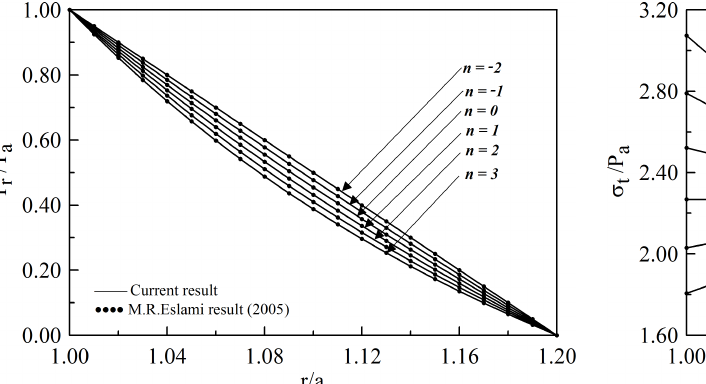
Figure 6: Radially distributed temperature